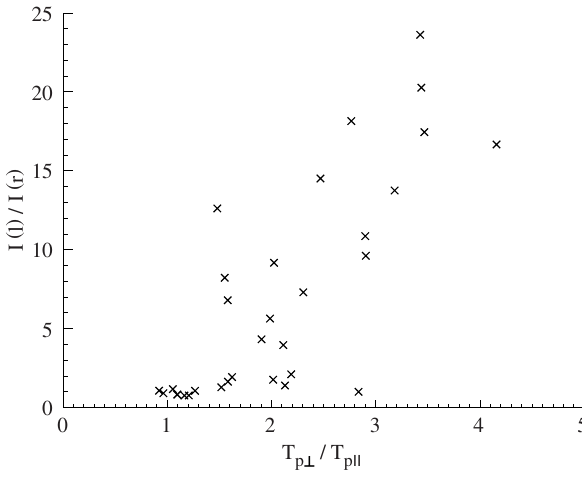
Fig. 6. Ratio of the left-hand polarized to the right-hand polarized component I(l)/I(r) against the proton temperature anisotropy T p ⊥ /T p k of 32 2-min intervals from 4 to 8min downstream of the quasi-perpendicular low- β bow shock.